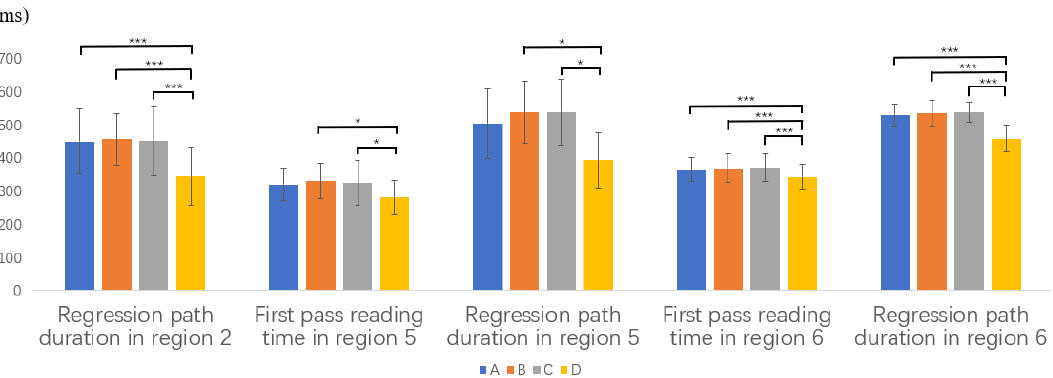
Figure 2. Part of representative reading measures for intermediate L2 learners (* p < 0.05, *** p < 0.001).